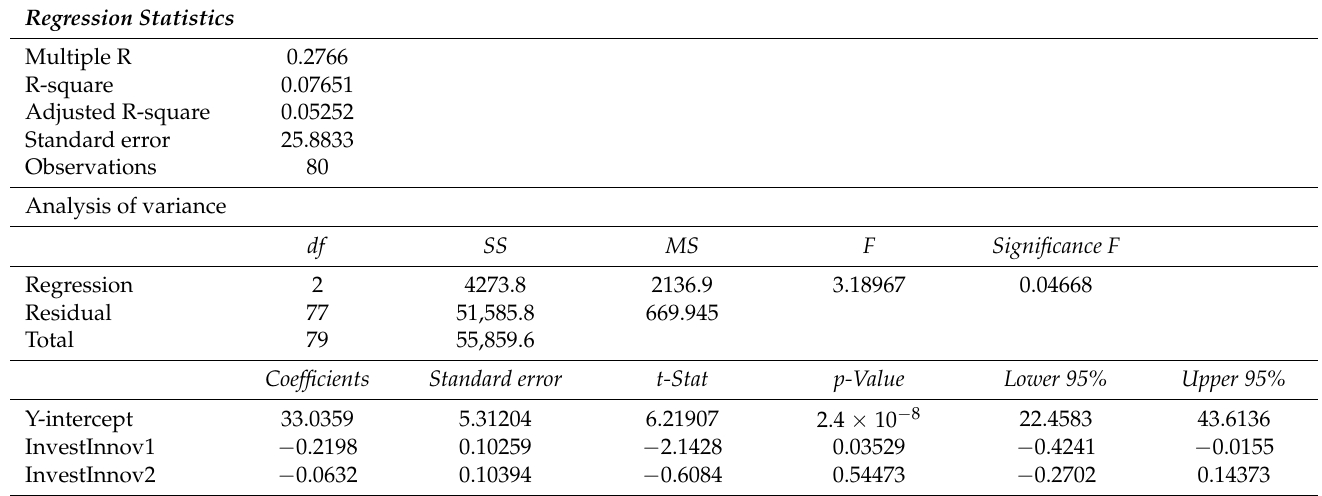
Table A2. Regression statistics of the dependence Srisk 2 on investments in innovation